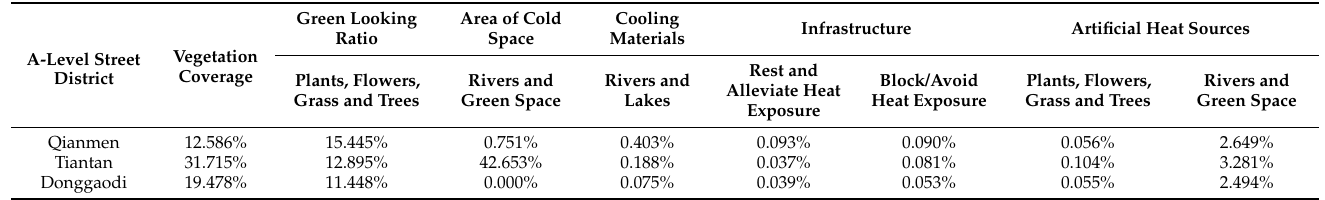
Figure 7. Translating and computing process of street view pictures in high-risk heat exposure street districts. Table 4. Statistics of elements of the A-level high-risk heat exposure